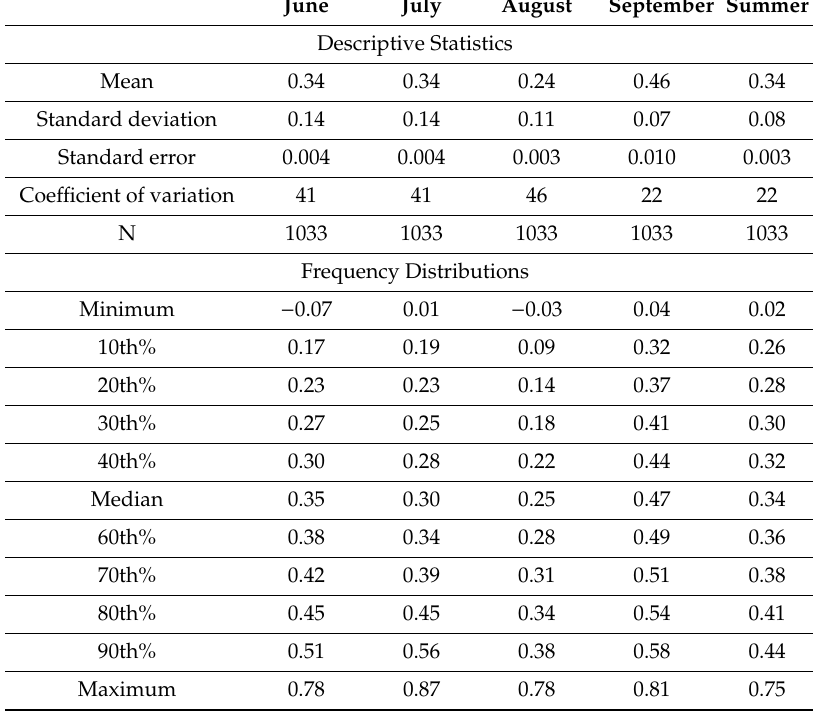
Table 2. Summary statistics for the distributions of rates of temperature change ( ◦ C decade − 1 ) in the period 1981–2018 for 1033 lakes in the conterminous United